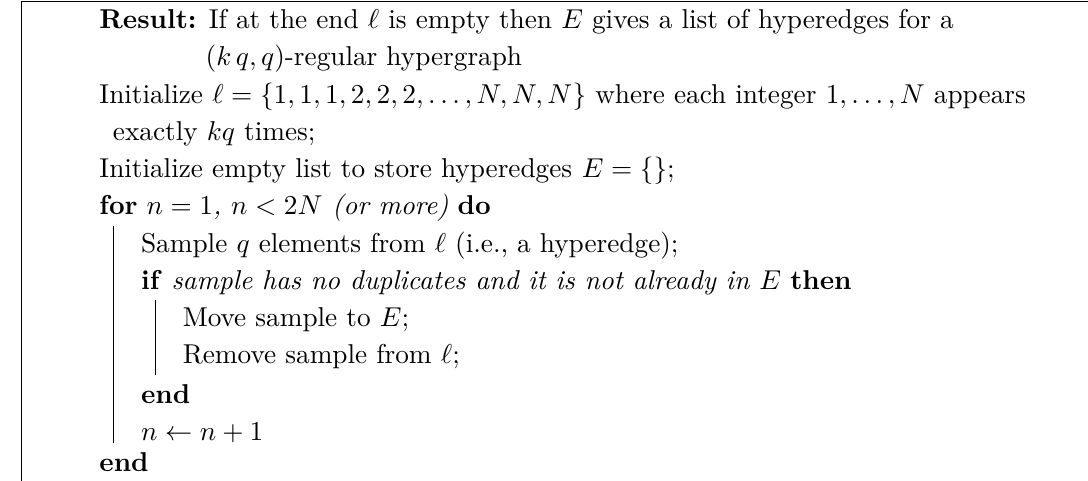
Algorithm 1 . Generate a ( k q, q ) -regular